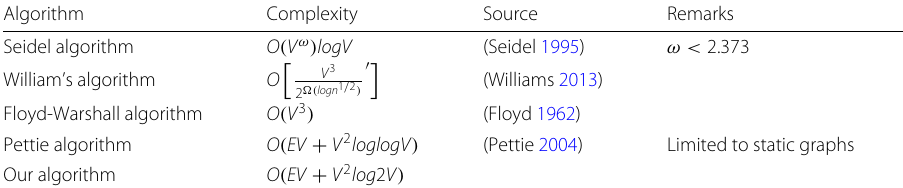
Table 1 A benchmark comparison for the algorithms’